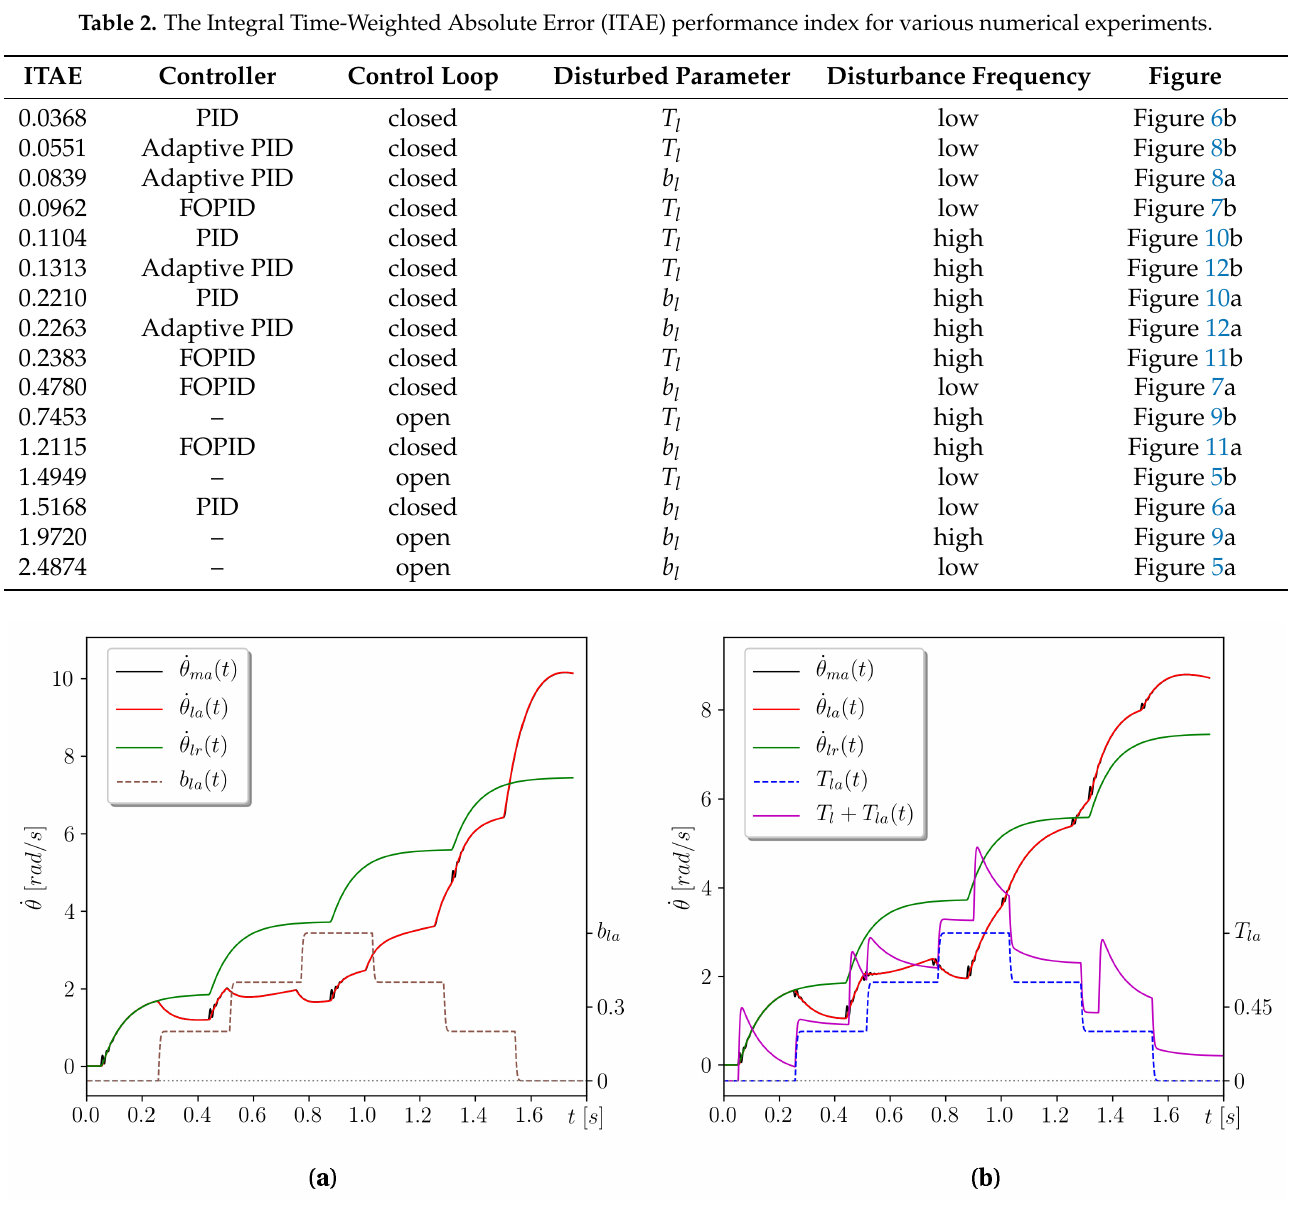
Figure 5. The open-loop reference model control system response at the presence of the additional time-dependent disturbances of: ( a ) damping of load b la ( t ) —see on the right-hand vertical axis; ( b ) load T la ( t ) with adaptation of PID parameters and PI compensation of error dynamics. Green line represents the desired rotational velocity trajectory, while the red line the actual velocity of the load (low-frequency